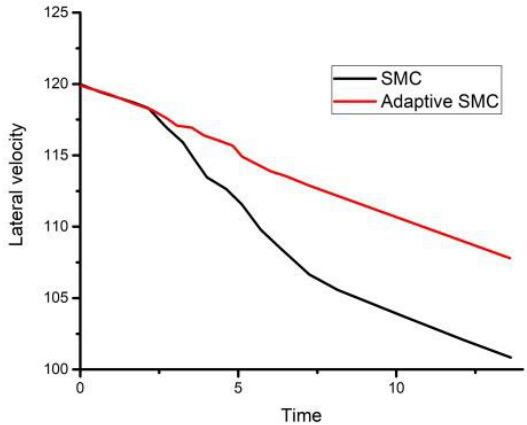
Figure 20. Lateral velocity.